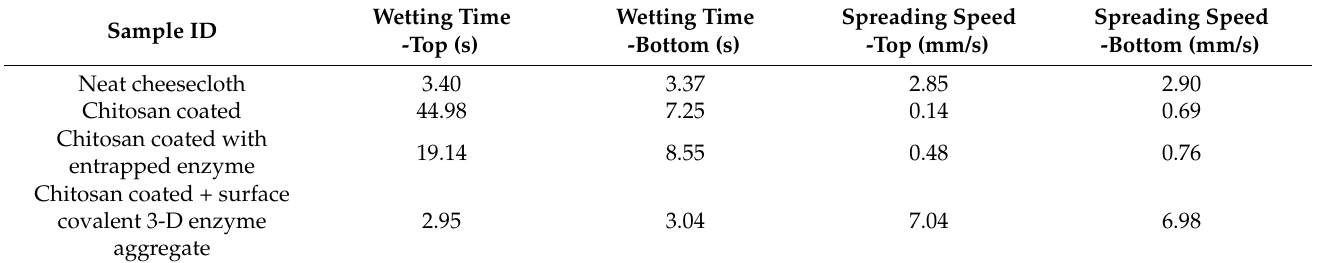
Table 2. MMT liquid transport properties of the cheesecloth support materials with different